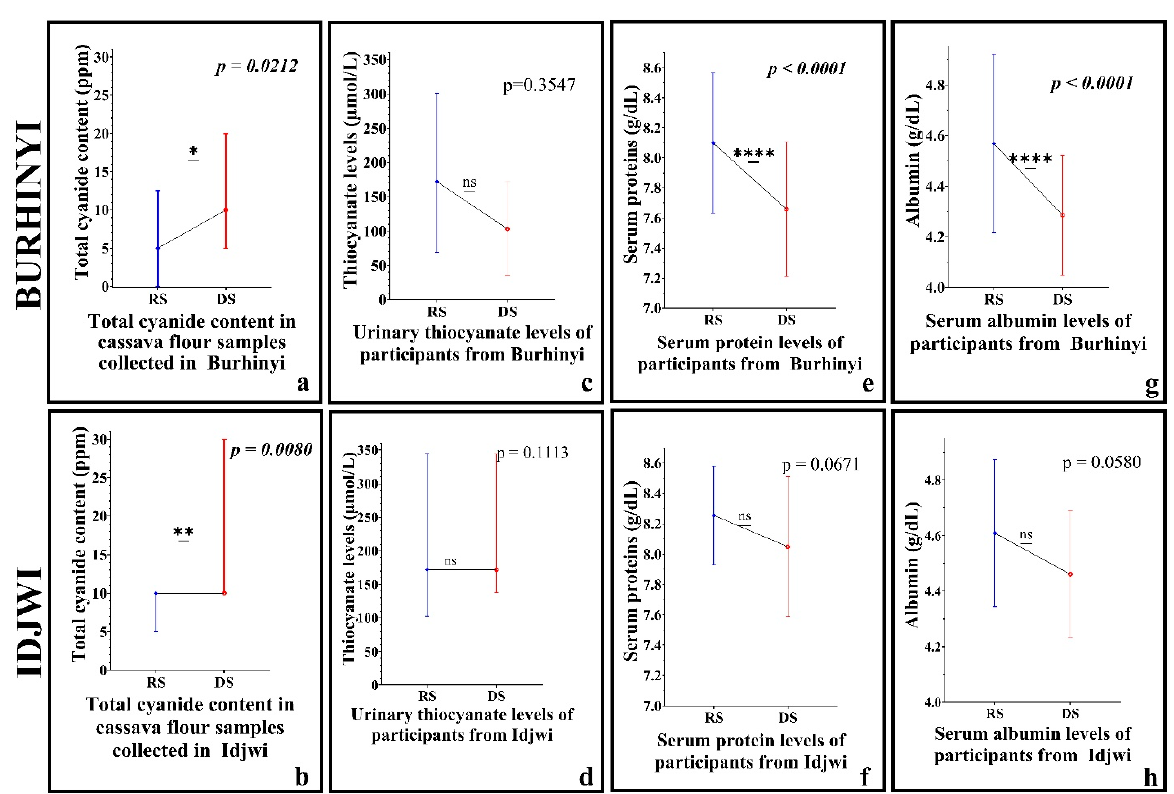
Figure 3. Seasonal variations of dietary cyanide exposure and nutritional status (serum proteins and albumin levels). This figure shows the impact of seasonal variation on 1° the total cyanide content in cassava flour samples: significant increase during the dry season in Burhinyi ( a ) and Idjwi ( b ), 2° the urinary thiocyanate levels: non-significant decrease in Burhinyi ( c ) and slight (non-significative) increase in Idjwi ( d ) during the dry season, and 3° the serum proteins and albumin levels: significant decrease during the dry season in Burhinyi ( e , g ) but not in Idjwi ( f , h ). Data are presented as a median with an interquartile range ( a – d ) or as mean with standard deviation ( e – h ). RS, rainy season; DS, dry season; ppm, parts per million; ns, not significant; * p < 0.05; ** p < 0.01; **** p < 0.0001.